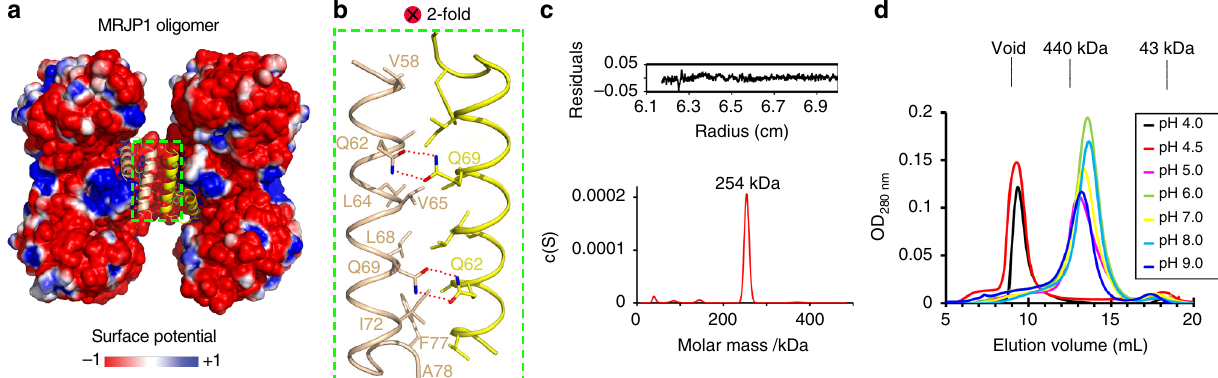
NATURE COMMUNICATIONS| (2018) 9:3373 |DOI: